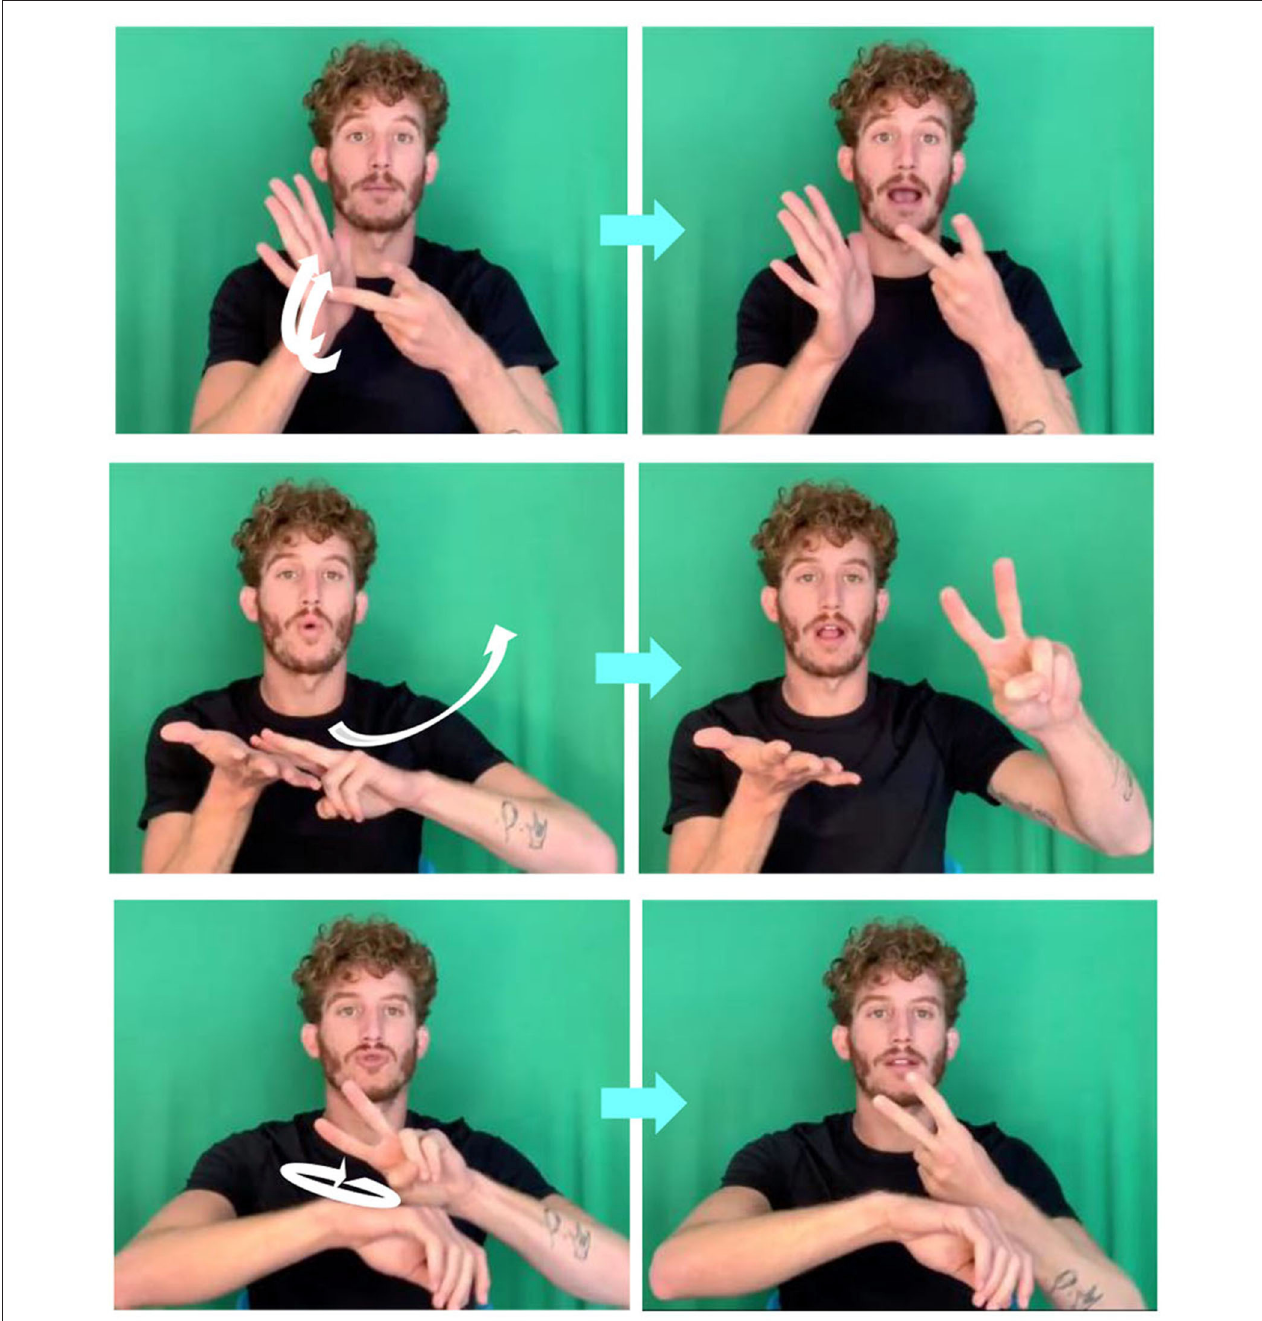
FIGURE 5 | Numeral incorporation in ISL. Top: TWICE , middle: TWO-MONTHS , bottom: TWO-HOURS (To see the videos, click the arrow in each of the picture pairs).